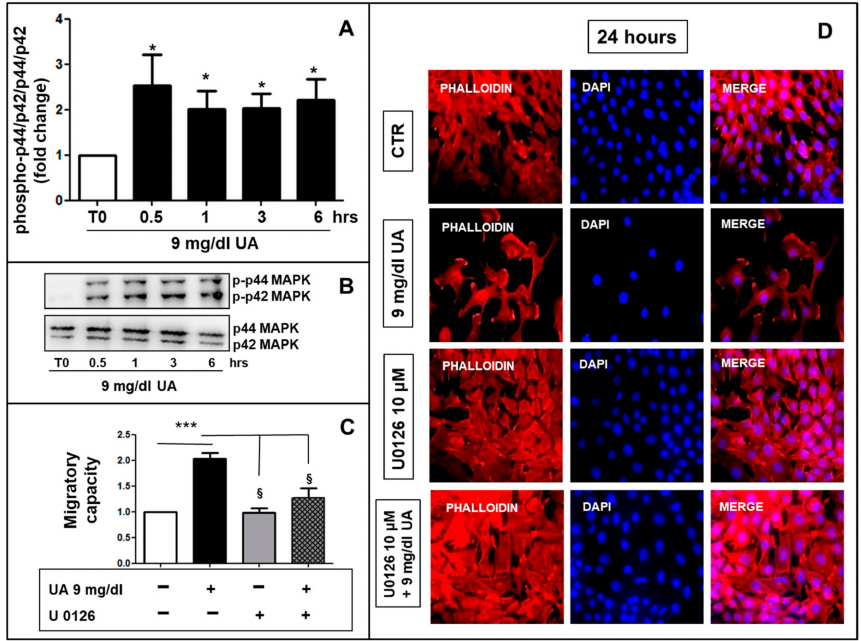
Figure 5. UA induced a time dependent p44/42 MAPK phosphorylation. ( A ) 9 mg/dL UA induced p44/42 MAPK phosphorylation (* p < 0.05 vs. T0), ( B ) as shown by Western blot analysis. ( C ) U0196 reversed migratory capacity as well as cortical F-actin distribution induced by UA (* p < 0.05 vs. T0, *** p < 0.0001 vs. CTR, § p < 0.05 vs. UA treated cells) ( D ) as visualized by AlexaFluor 594-Phalloidin staining. Magnification = × 200, scale bar = 30 µ m. All results represent means ± SEM obtained from three/four independent experiments and are expressed as fold change to T0 ( A , B ) or CTR ( C , D ). UA = Uric Acid; CTR = Control, untreated cells; MAPK = Mitogen-activated protein kinase; T0 = Time 0; hrs. = hours; DAPI = 4 (cid:48)